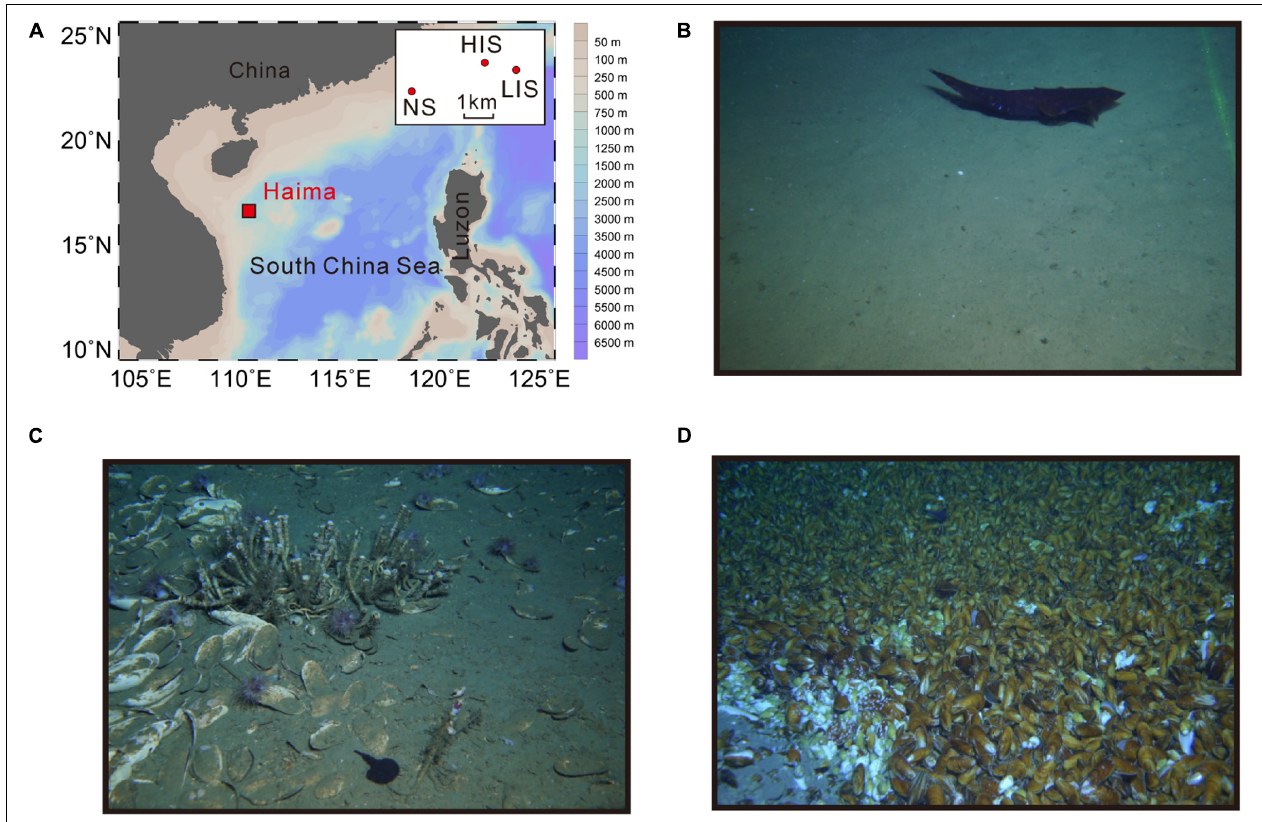
FIGURE 1 | Location and landscapes of the sampling sites. (A) Map of the sampling sites with water depth. The white box on the top right is a zoom-in of the Haima area with the locations of three sampling sites. Landscapes of the non-seepage (NS) site (B) , the low-intensity seepage (LIS) site (C) , and the high-intensity seepage (HIS) site (D)